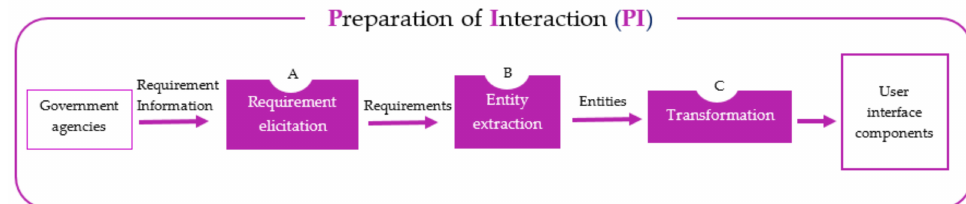
Figure 3. The Preparation of Interaction (PI)